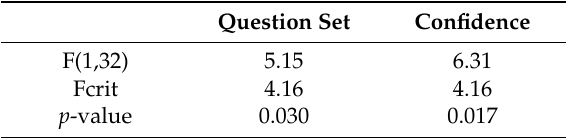
Table 3. One-way variance analysis test for the visualization literacy